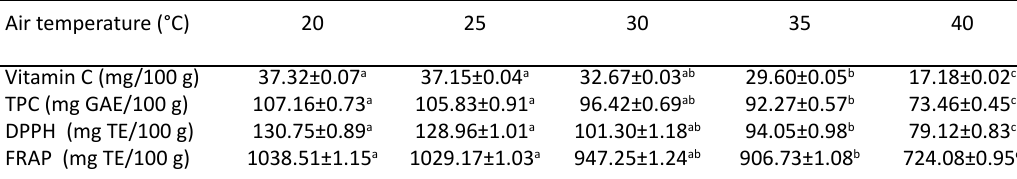
Table 5. Impact of air temperature in microwave-air dehydration to phenolic content and antioxidant capacity in dried